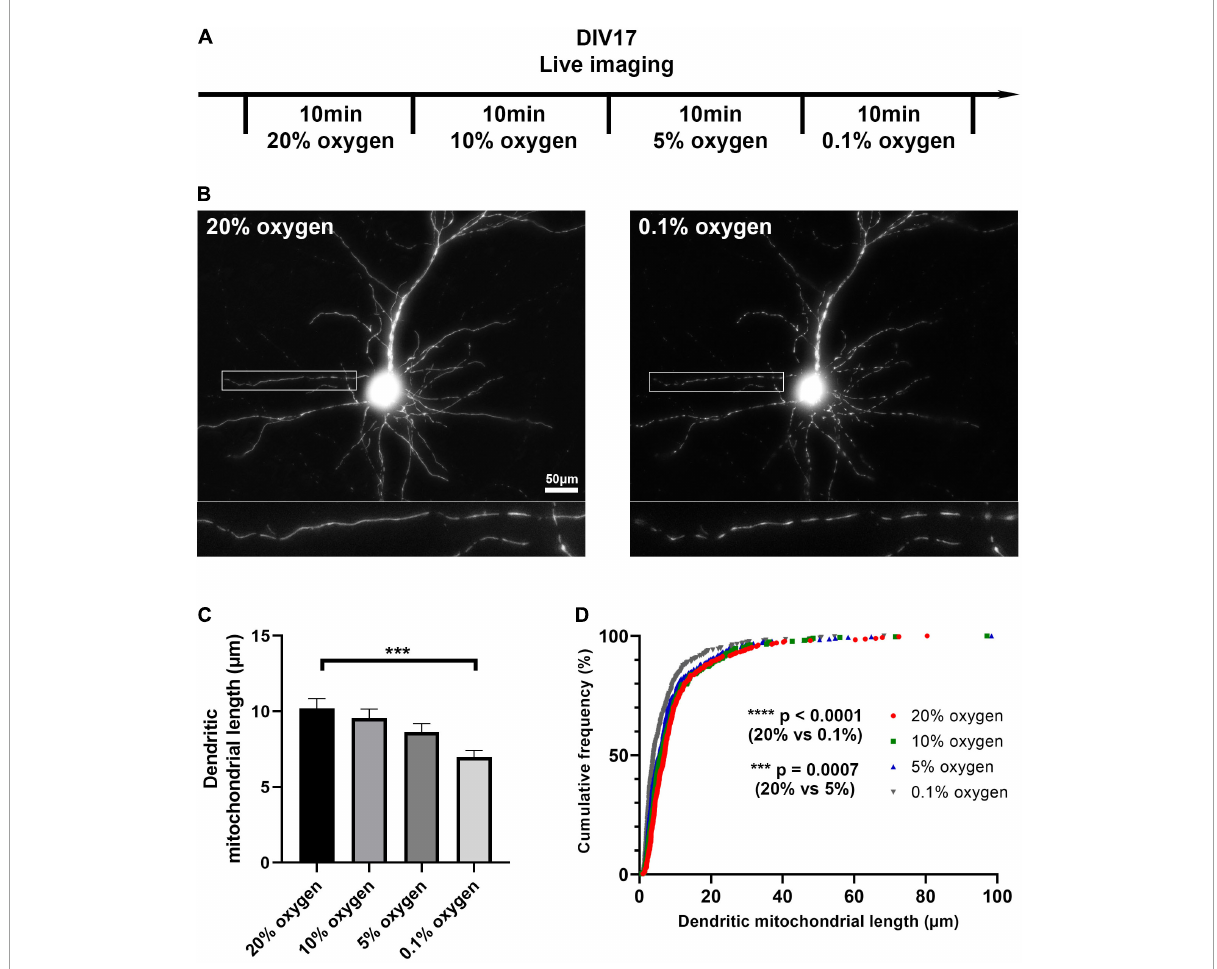
FIGURE4 Low oxygen level induces mitochondrial fragmentation in vitro . (A) Schematic diagram of live imaging. Live imaging of mitochondria-labeled cortical neurons was done in four different oxygen levels; 20, 10, 5, and 0.1%. (B) Representative images of mitochondria in 20 and 0.1% oxygen level. (C) Quantification of dendritic mitochondrial length showed gradual decrease as oxygen level dropped. (D) Cumulative frequencies of dendritic mitochondrial length also showed shorter mitochondria in low oxygen level, compared to normal oxygen level. n 20% oxygen = 2 cultures, 26 dendrites, 316 mitochondria, n 10% oxygen = 2 cultures, 26 dendrites, 323 mitochondria, n 5% oxygen = 2 cultures, 26 dendrites, 330 mitochondria, and n 0 . 1% oxygen = 2 cultures, 26 dendrites, 346 mitochondria. Kruskal–Wallis test with Dunn’s multiple comparisons test. Length: *** p = 0.0007 for 20% oxygen vs. 5% oxygen, **** p < 0.0001 for 20% oxygen vs. 0.1% oxygen. Scale bar, 20 µ